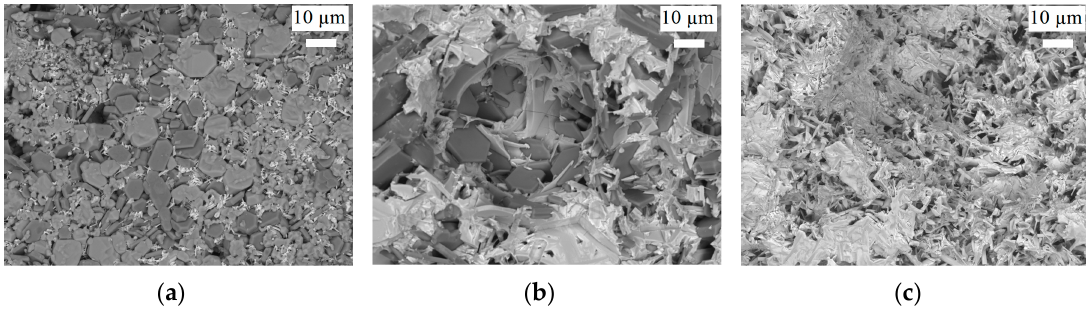
Figure 3. SEM images of barium hexaferrite single crystals grown from various PbO fluxes: ( a ) PbO 60 at %, 1473 K; ( b ) PbO 70 at %, 1298 K; ( c ) PbO 80 at %, 1223 K.